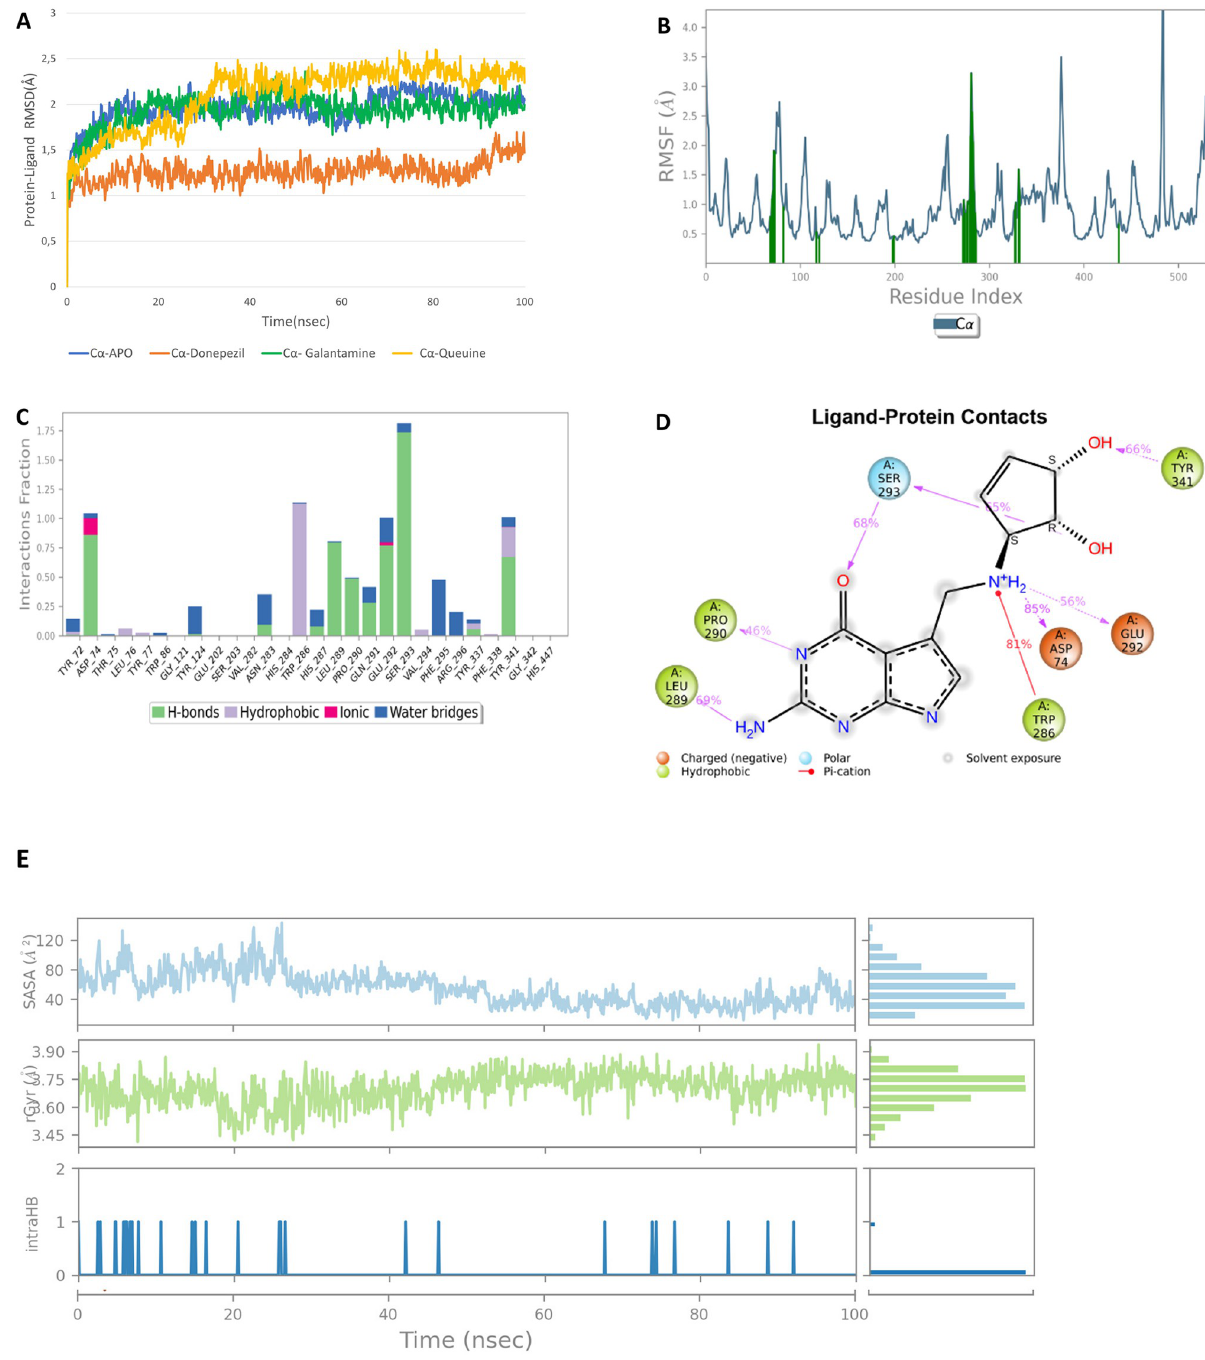
Fig 3. Molecular dynamics results of Queuine: RMSD (A), RMSF (B), protein-ligand fractions (C), protein-ligand contacts (% of simulation time) (D), SASA, radius of gyration and intramolecular hydrogen bonding (E) plots for Queuine.